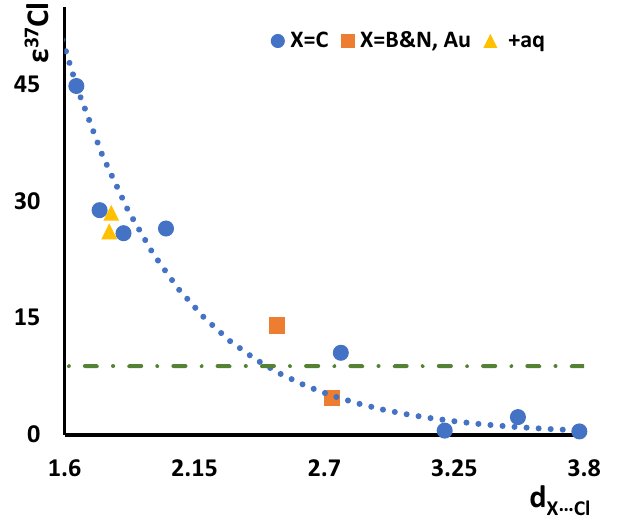
Figure 2. Dependence of the chlorine isotopic fractionation (ε 37 Cl in ‰) on the distance (d X … Cl in Å) of chloride from the nearest atom of the nanostructure. Blue circles refer to the distance from the carbon atom. Yellow triangles refer to the distance from the carbon atom in cases with continuum models of solvent included. Distances from Au and B are represented by orange squares (see Table 1 for numerical values). The green line at about 9 ‰ corresponds to the maximum equilibrium isotope effect.